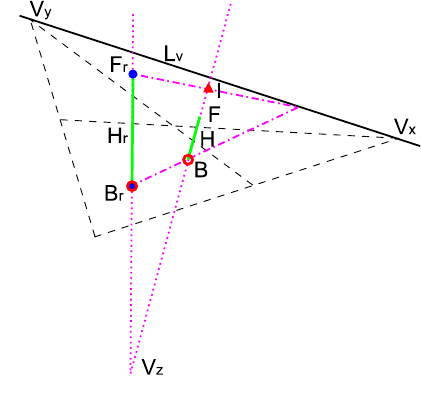
Figure 5. Feature points